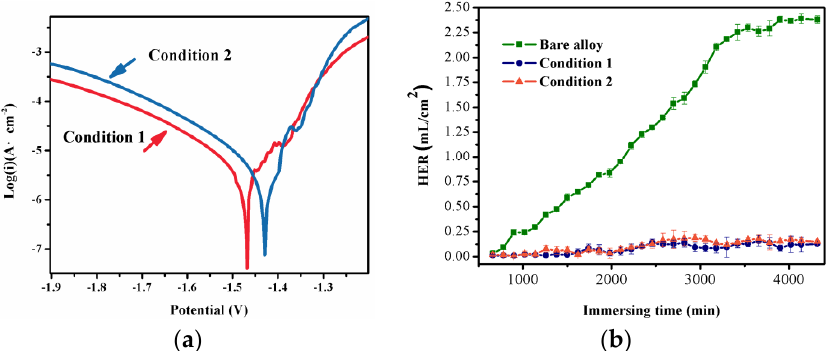
Figure 5. Polarization curves ( a ) and the hydrogen evolution rate (HER) ( b ) for the coatings in conditions 1 and 2. The HER curve shows the bare alloy for comparison. Table 5. Electrochemical data for the coatings in conditions 1 and 2, obtained via equivalent circuit fitting of EIS curves.